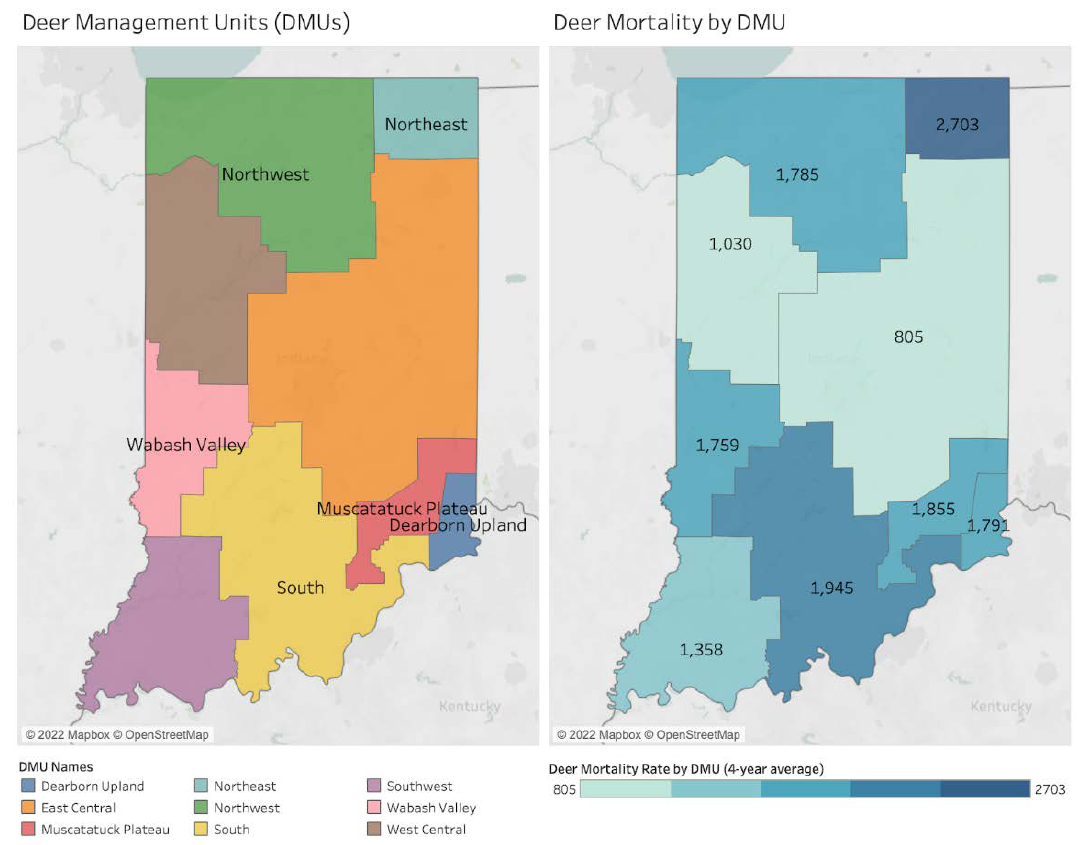
Figure 10. Deer mortality rates by DMU (4-year average, 2017–2020).